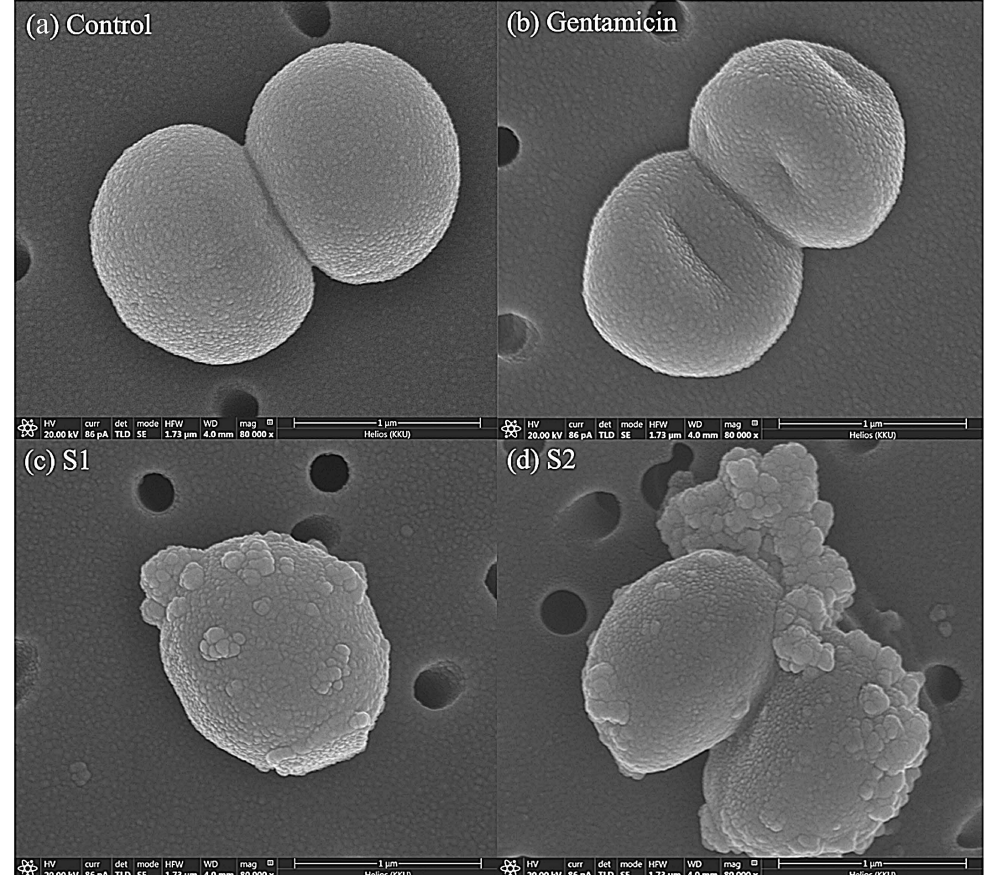
Figure 2. Cell morphological change of S. pseudintermedius MIC 411 observed by FIB-FESEM. Control cell ( a ). The bacterial cells were treated at concentration of MBC level for 1.5 h with gentamicin ( b ), AgNSs ( c ), and anisotropic AgNPs ( d ).Bacterial cell treated AgNPs ( c , d ) show the distorted cell, membrane blebbing, membrane damage, and clumping around the